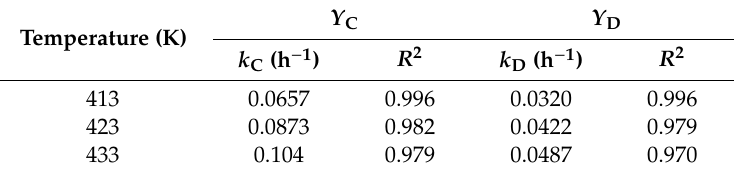
Figure 12. Relationship between reaction kinetic function ( a ) Y C –t; ( b ) Y D –t at different temperatures. Table 7. Reaction rate constant k C ; k D and correlation coe ffi cient R 2